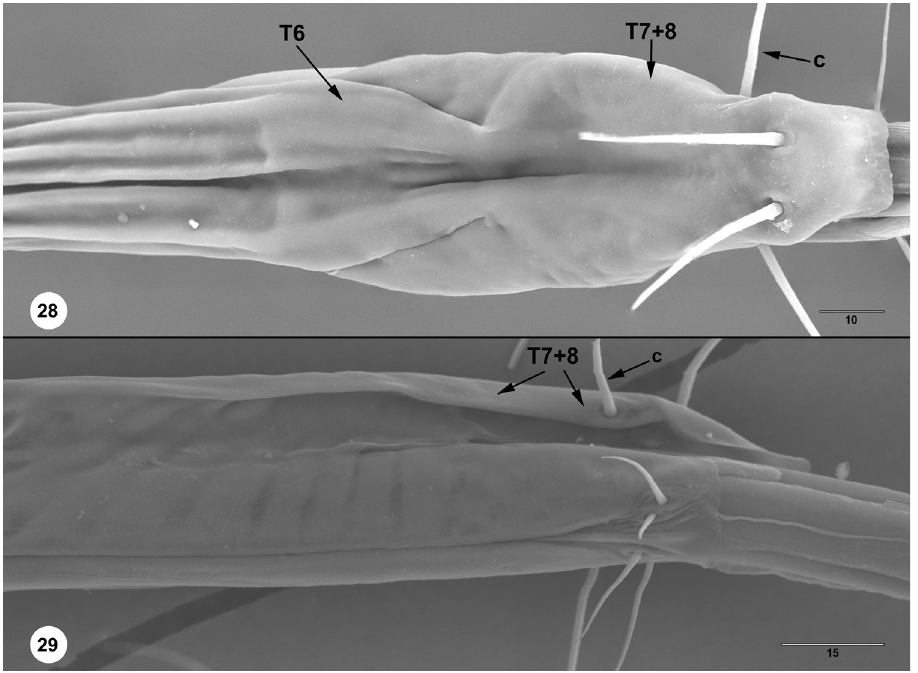
Figures 28–29. Platygaster tubulosa , female (USNMENT01109983) 28 T6–T8, dorsal view 29